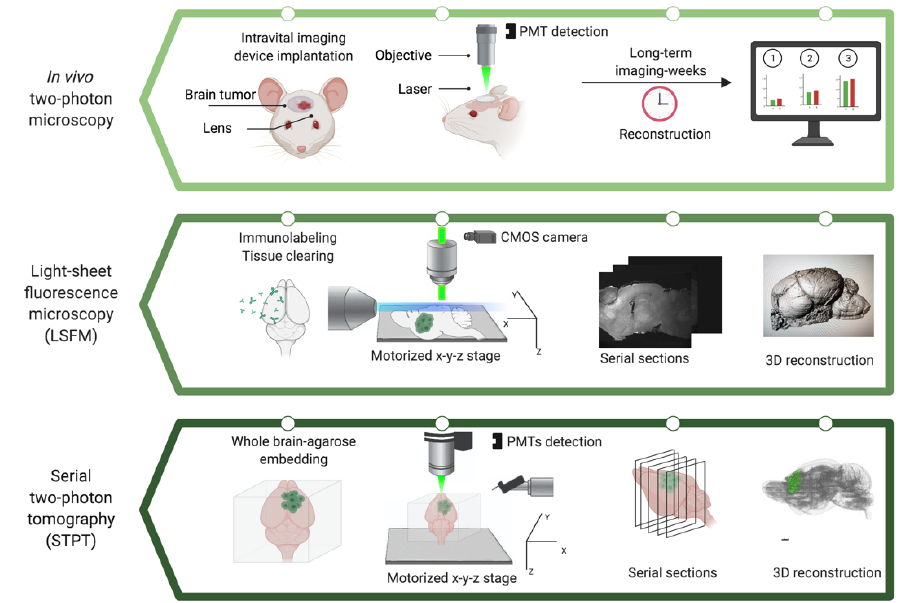
Figure 2. Schematic of 3D microscopes and their workflows for tumor reconstruction. Example reconstructed brains are shown for light-sheet fluorescence microscopy and serial two-photon tomography. PMT, photomultiplier tube; CMOS, complementary metal-oxide-semiconductor; 3D, three-dimensional. The figure was created with BioRender.com (accessed on 12 March 2021) and was exported under a paid subscription.